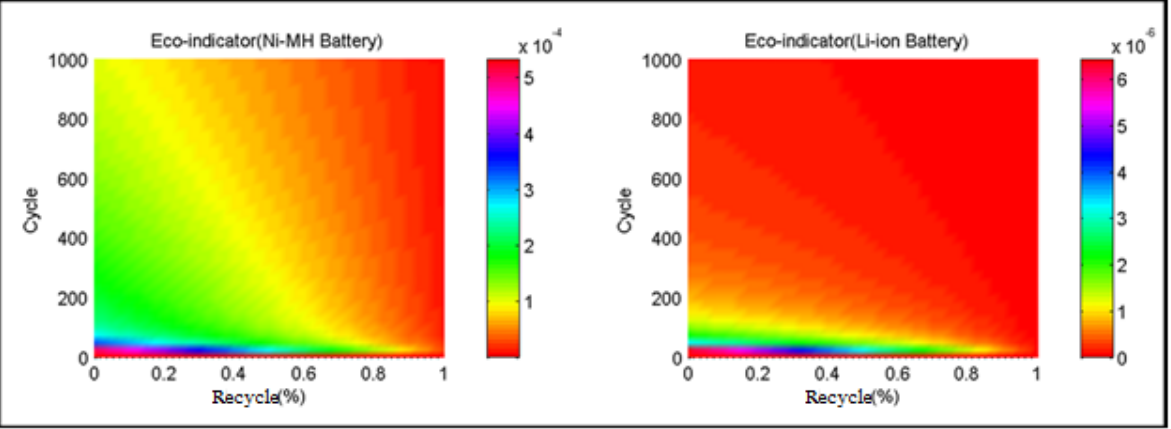
Figure 6. Influence of cycles and recycle rate on the Eco-indicator of the two selected batteries.